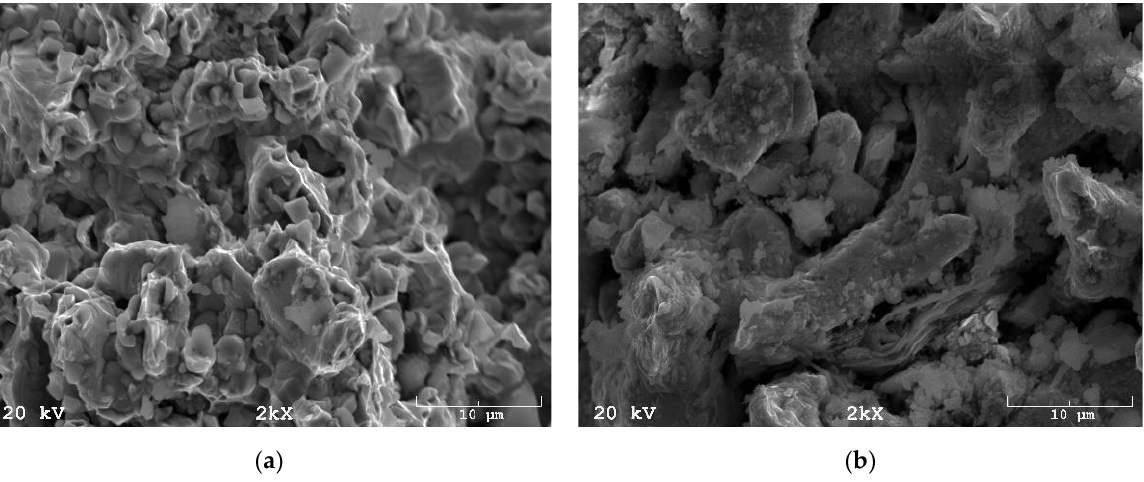
Figure 11. Microstructure of composites with: ( a ) 5% wt. of tuff at a magnification of 2000×; ( b ) 30% wt. of tuff at a magnification of 2000X.